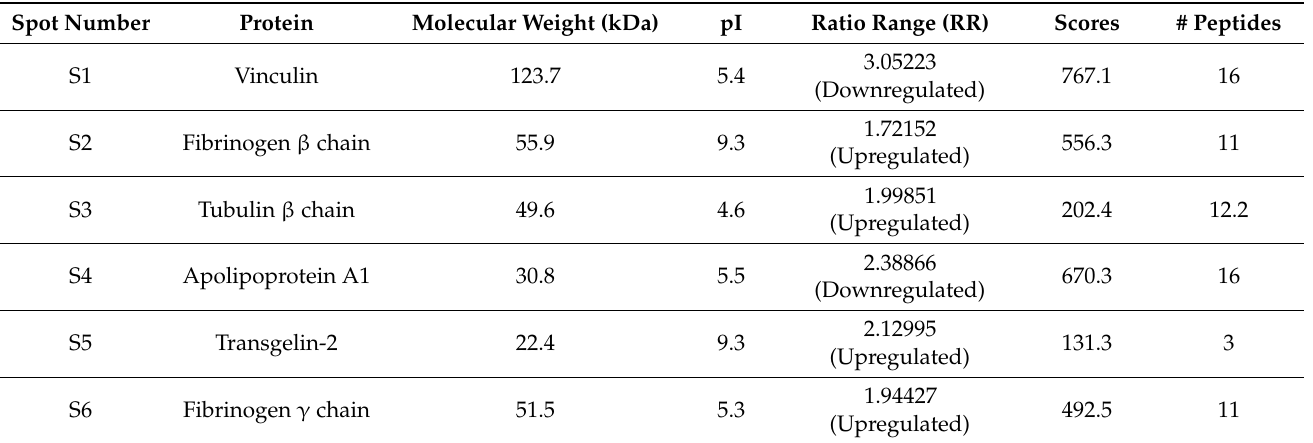
Table 1. List of identified proteins with altered expression in ACS patients in comparison to healthy donors by nanoscale liquid chromatography coupled to tandem mass spectrometry.